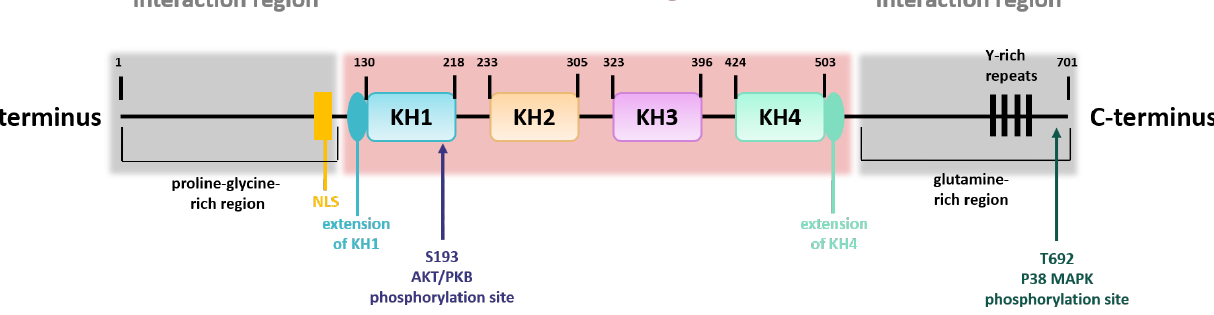
Figure 1. KSRP structure. Schematic overview of KSRP protein structure, including the domain or- ganization in the central region, involved in RNA interaction, and the two N- and C-terminally flanking regions, which are necessary for protein interaction. Phosphorylation sites are indicated (own illustration inspired by [10]).